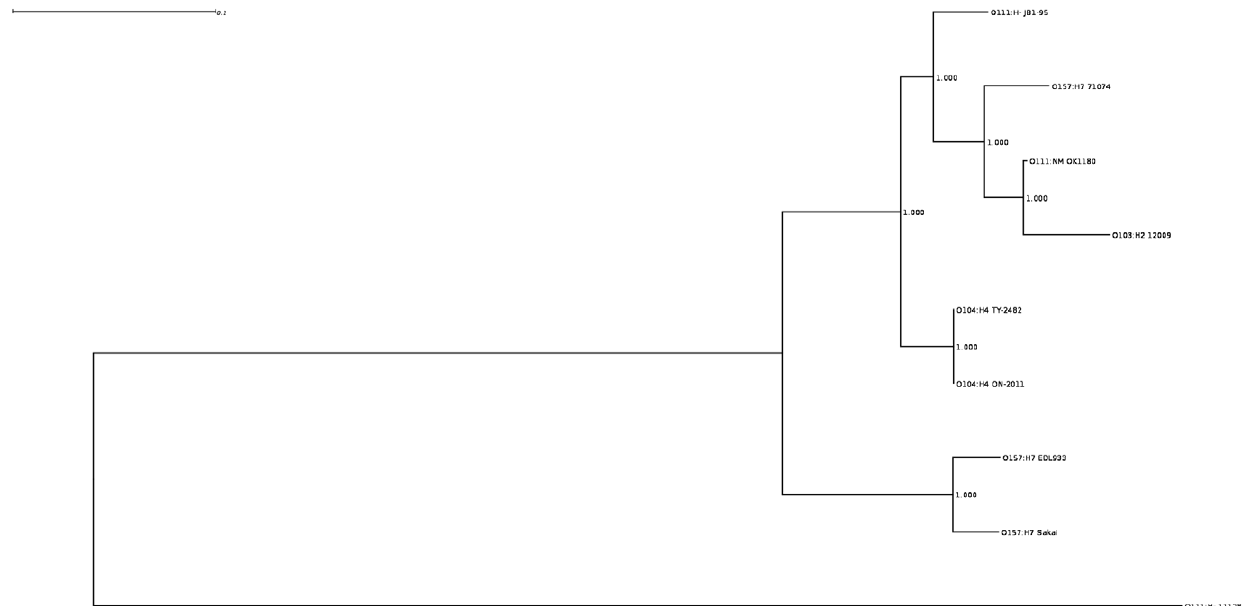
Figure 5. Maximum likelihood phylogram with aLRT branch-support values of the MAFFT alignment of the Stx2-bacteriophage closely related to the O104:H4 outbreak isolates.